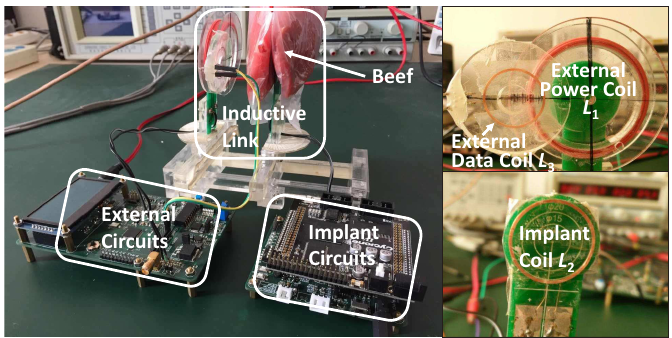
Figure 10. The prototype system is implemented to setup measurements of power and uplink data transmissions with beef